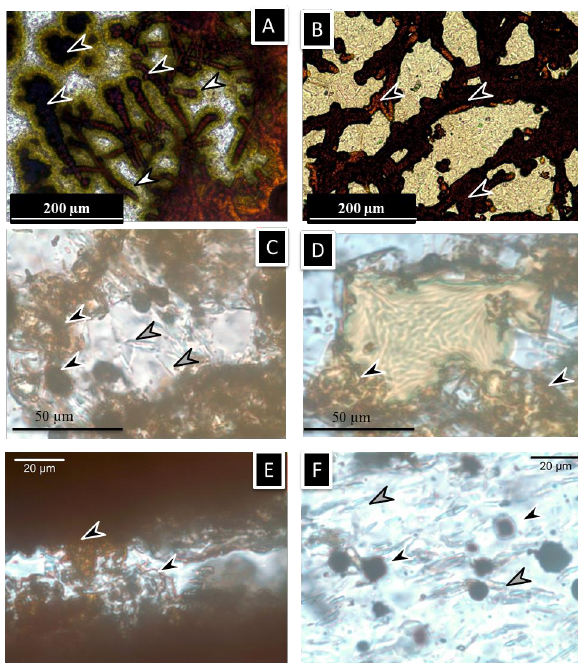
Figure 2. Microbially mediated mineralized biosignatures in me- teorites fallen in Hungary (Mező-Madaras, Knyahinya, Mócs, Nyírábrány and Kaba) (Polgári et al. 2017a,b, Polgári et al. 2018a, this volume). A: Sketch of microbial features (Bérczi, personal comm. 2017). B: microbial features in Kaba CV3 meteorite (black arrows). C: Coccoidal FeOB in Knyahinya L5 sample (black arrow). D: Microbial mediation of troilite by filamentous FeOB (black arrows) with clay mineralization of EPS (white arrow) in Mócs L6 chondrite (reflected light) E: Alteration of olivine by filamentous and coccoidal FeOB in Mezőmadaras L3 chondrites. (black arrows) (transmitted light). F: Microbial mediation of Nyírábrány LL5 chondrite by fila- mentous FeOB (black arrows) with clay mineralization (white ar- rows) (transmitted